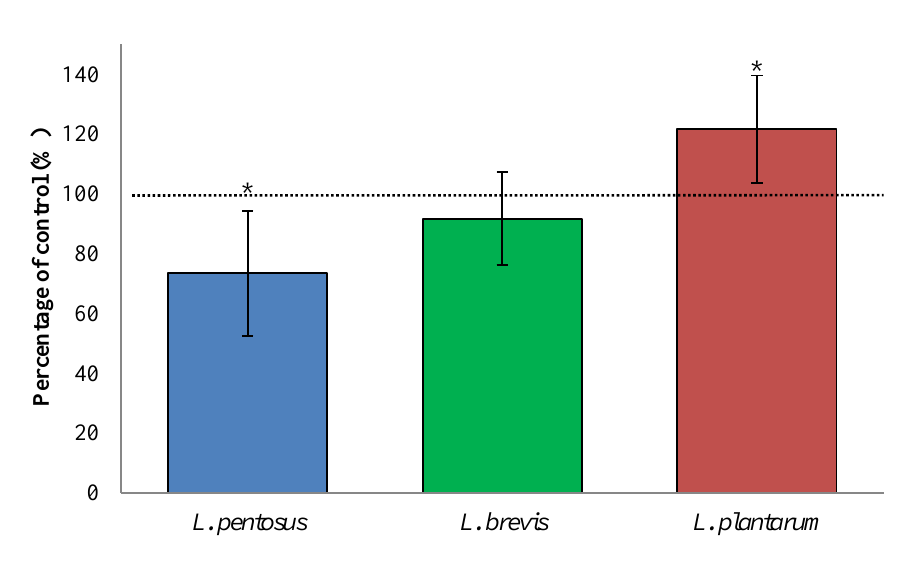
Figure 1. This bar graph shows the change in number of the TG2 binding motif QLP, specific to α 2 -gliadin, which remains available for TG2 binding after lactic fermentation and in vitro digestion of wheat flour. Wheat flour fermented with L. brevis , L. pentosus , or L. plantarum was compared to unfermented breads (control = 100%). Data are presented as means ± SD ( n = 8–12) and shows the change 73%–122% of control. The asterisk indicates a significant change ( p < 0.05) from control.